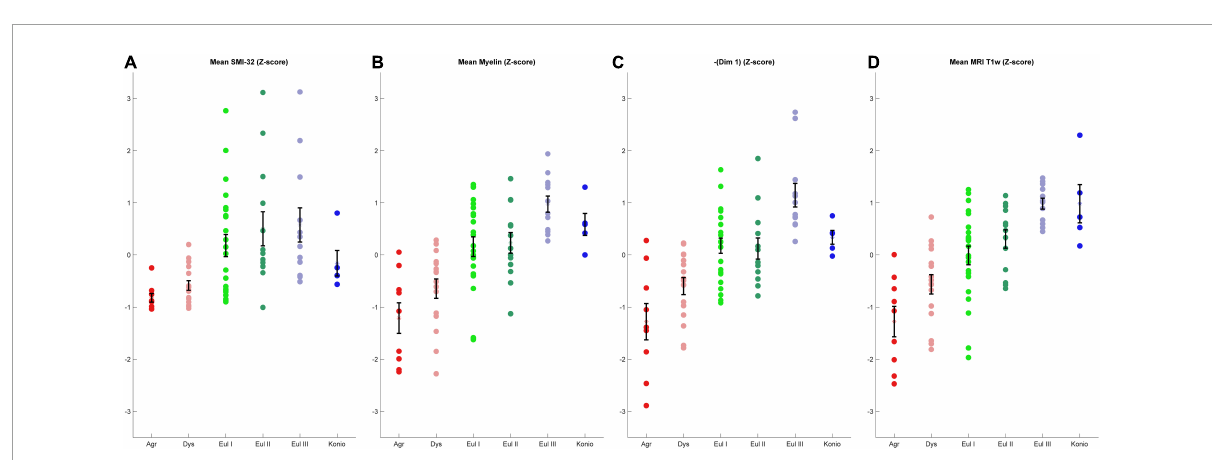
FIGURE8 Comparison of four coarse-grained measurements that reflect the limbic-to-eulaminate spectrum. (A) Mean SMI-32 RGL. (B) Mean myelin RGL. (C) Sign-flipped MDS Dimension 1. (D) T1-weighted data. All data are z-scored. Error bars show standard error of the